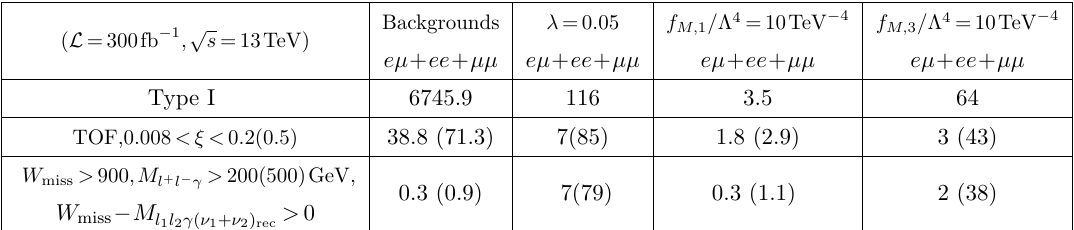
Table 5 . The yield of the SM backgrounds and few signal samples after applying the Type I cut, modi(cid:12)ed Type II, and Type III cuts for 300 fb (cid:0) 1 IL. The considered signal samples are (cid:21) = 0 : 05 and f M; 1 = (cid:3) 4 = f M; 3 = (cid:3) 4 = 10TeV (cid:0) 4